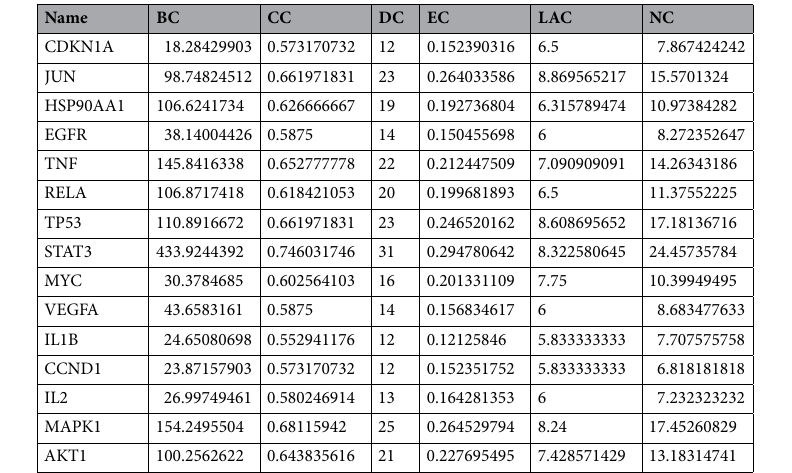
Table 2. Information on 15 core targets.